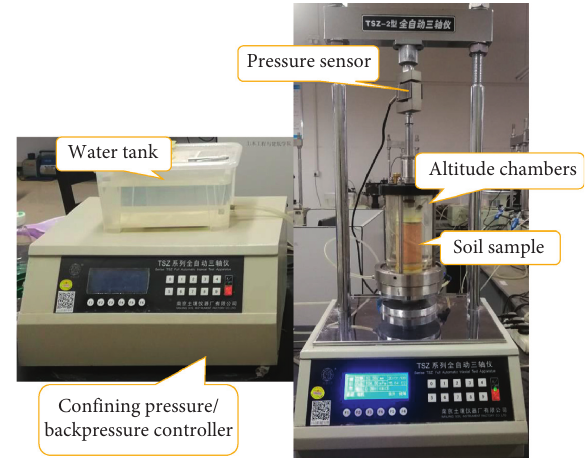
Figure 4: TSZ series of fully automatic triaxial